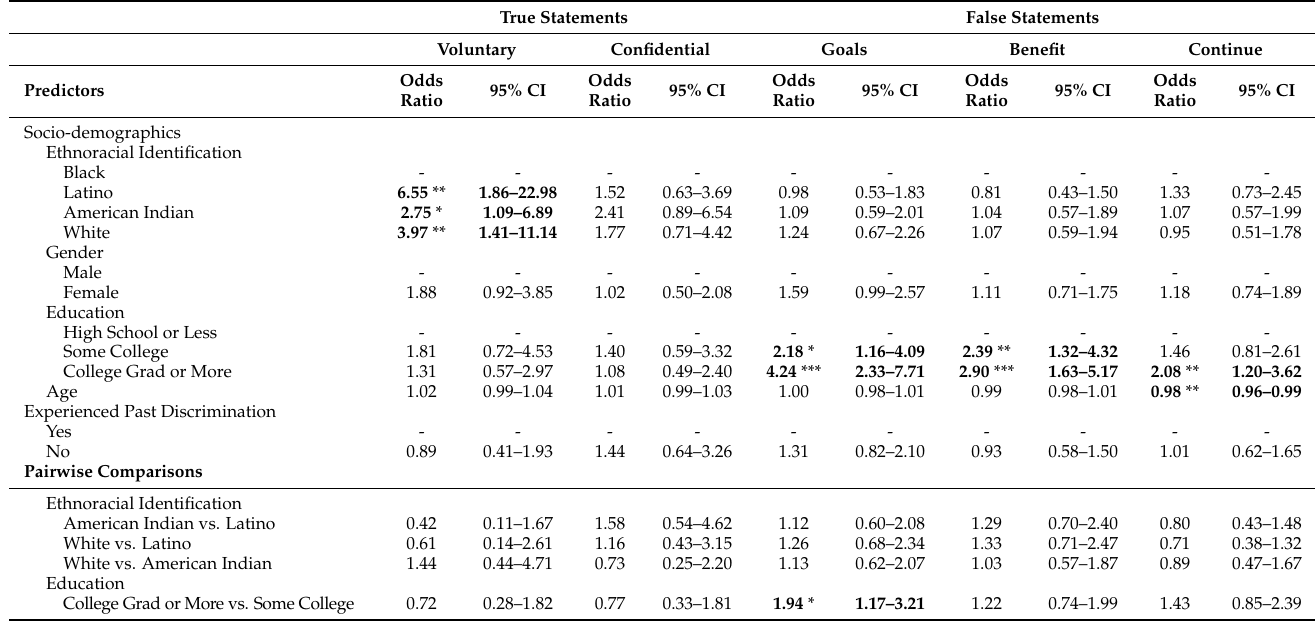
Table 5. Bivariate Logistic Regression Models of Providing a Correct Answer to the Individual MRL Questions on the Predictor Variables.